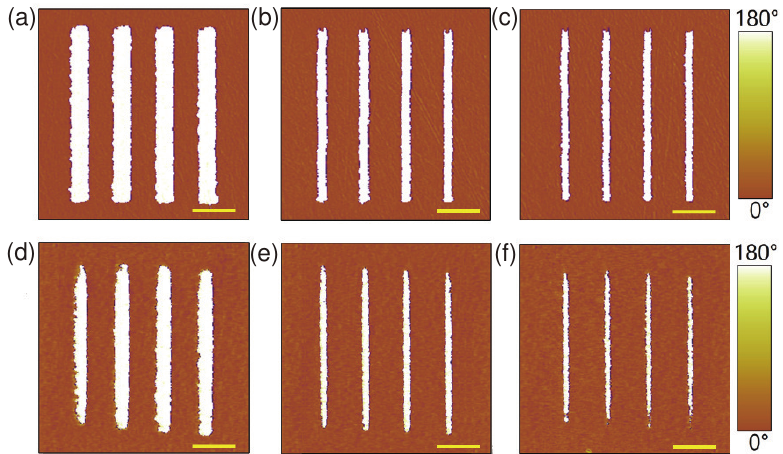
Figure 2. ( a – c ) Piezoresponse force microscope (PFM) images of as-written stripe domains with different stripe widths before the thermal annealing treatment. ( d – f ) The corresponding PFM images of stripe domains after the thermal annealing treatment at T = 120 ◦ C for 1 h. The length of the stripe domains was set to be ∼ 4 µ m. The scale bar in all figures is 1 µ